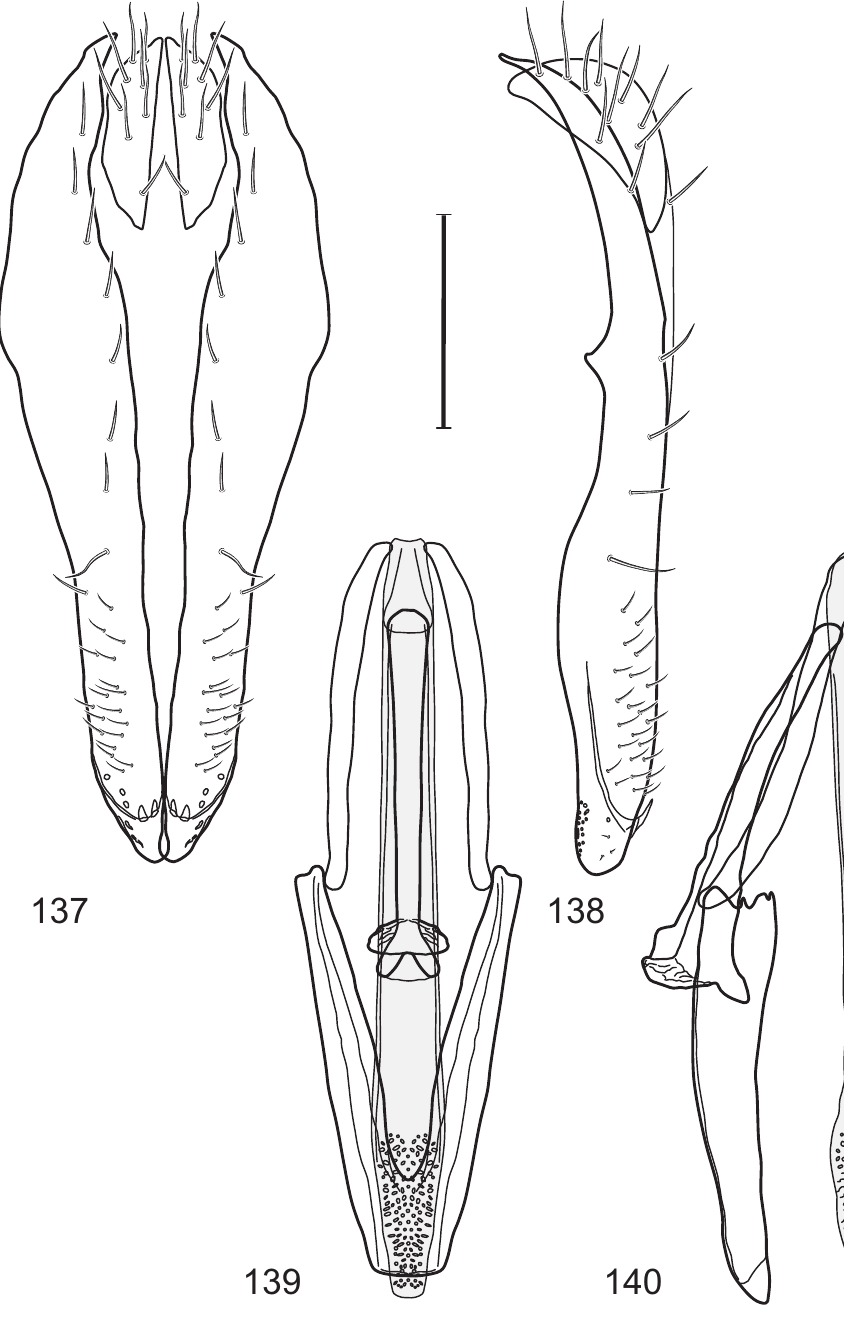
Figures 137–140. Hydrochasma annae sp. n. (USA. Utah. Grand: Green River) 137 epandrium and cerci, posterior view 138 same, lateral view 139 internal structures of male terminalia (aedeagus [shaded], phallapodeme, gonite, hypandrium), ventral view 140 same, lateral view. Scale bar = 0.1